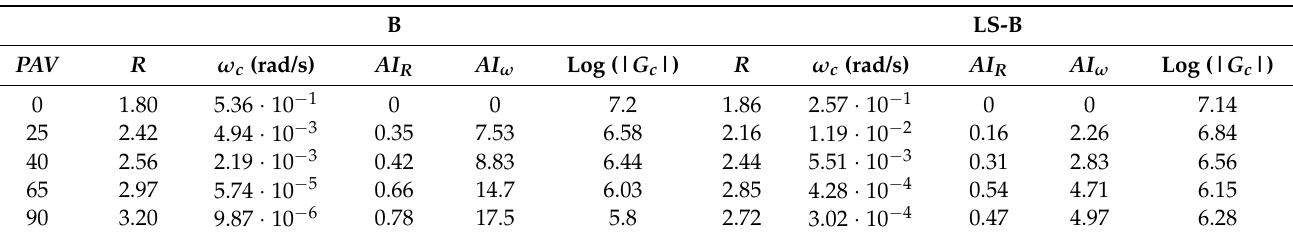
Table 1. Values of R , ω c , and log(| G c |) from the experimental master curves and the corresponding aging indexes defined in Equation